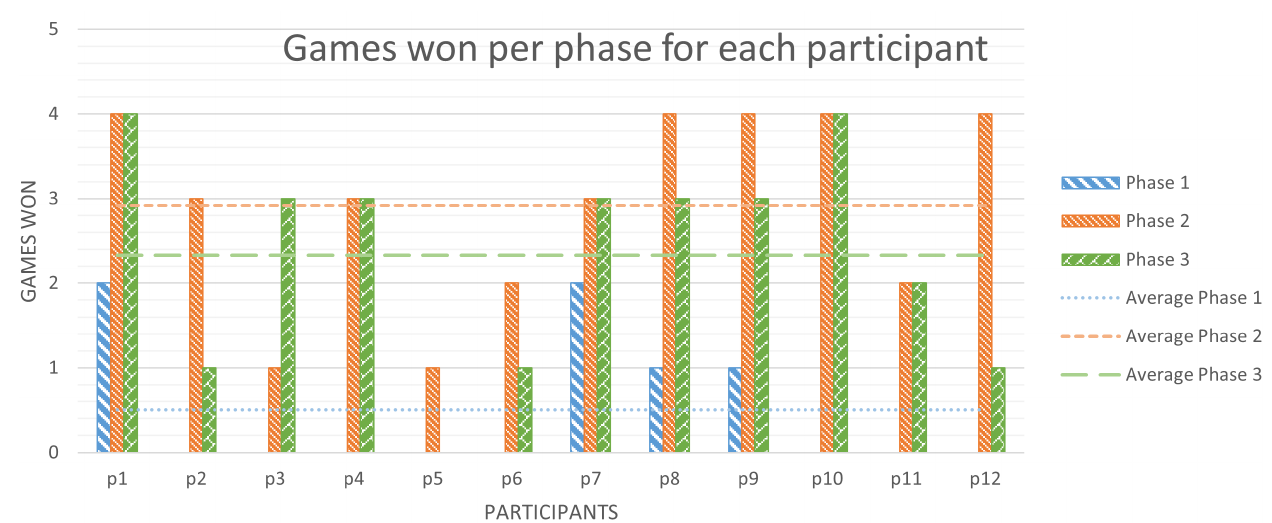
Figure 8. Average games won per phase for each